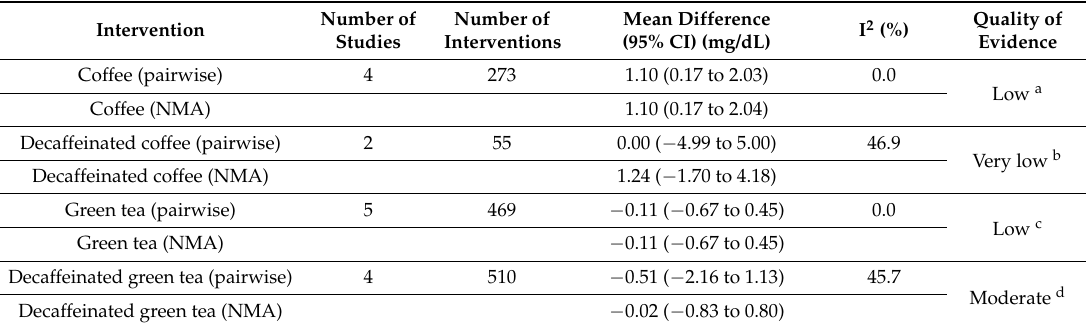
Table 5. Intervention effect on fasting blood insulin vs.